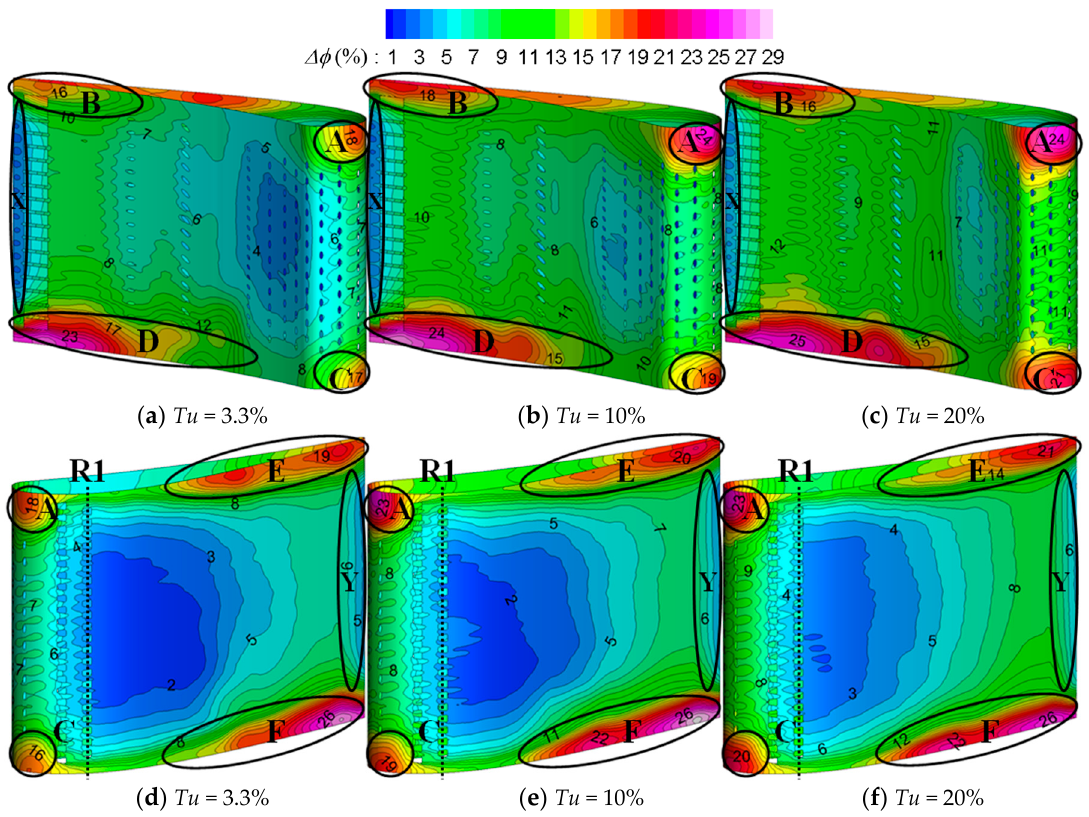
Figure 11. Effects of TBC on overall cooling effectiveness ( a – c ) on the PS; ( d – f ) on the SS at three Tus .